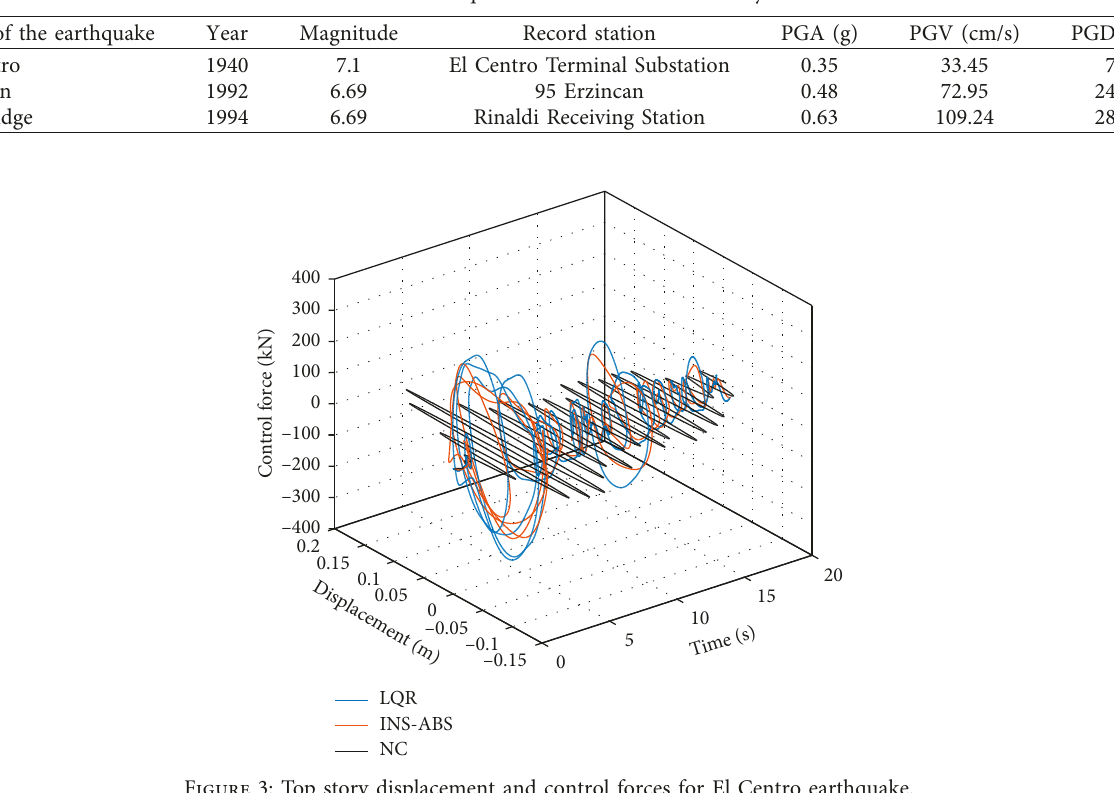
Table 1: Earthquake records used in this study.